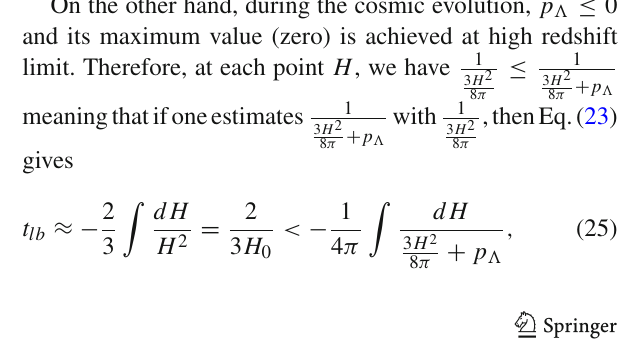
Fig. 6 The behavior of w T (cid:7) against deceleration parameter for D 2 = 0 . 3136, (cid:8) 0 m = 0 . 315, H 0 = 67 . 9 and δ = 947